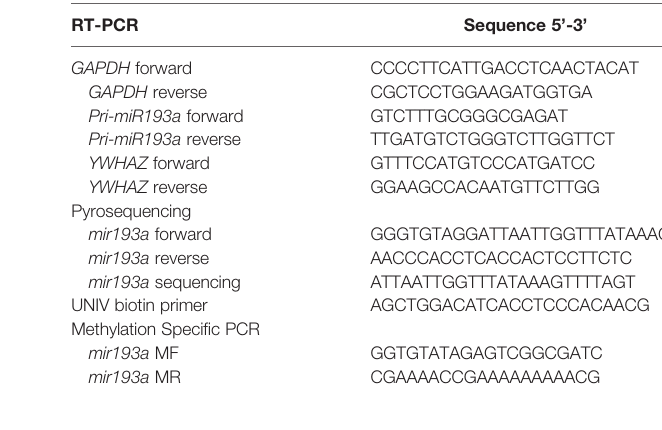
TABLE 3 | Primer sequence used in this study.